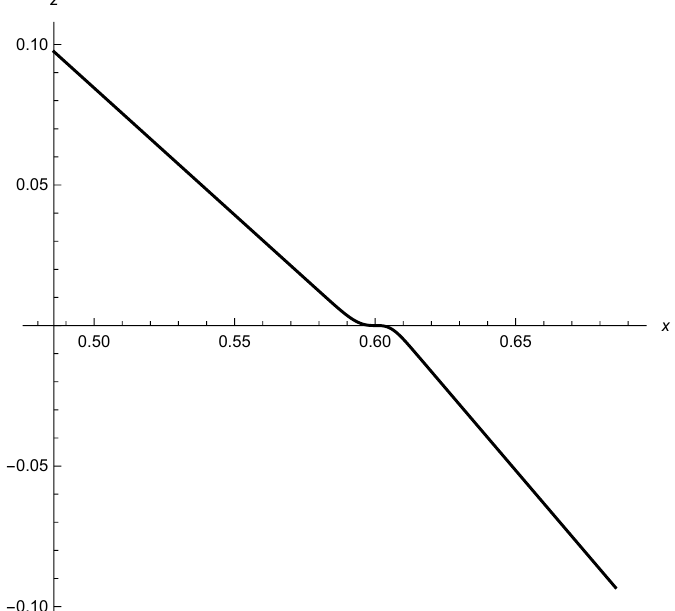
Figure 18. Trajectory of the particle in the x - z plane, considering H 3 , the initial conditions I and λ =